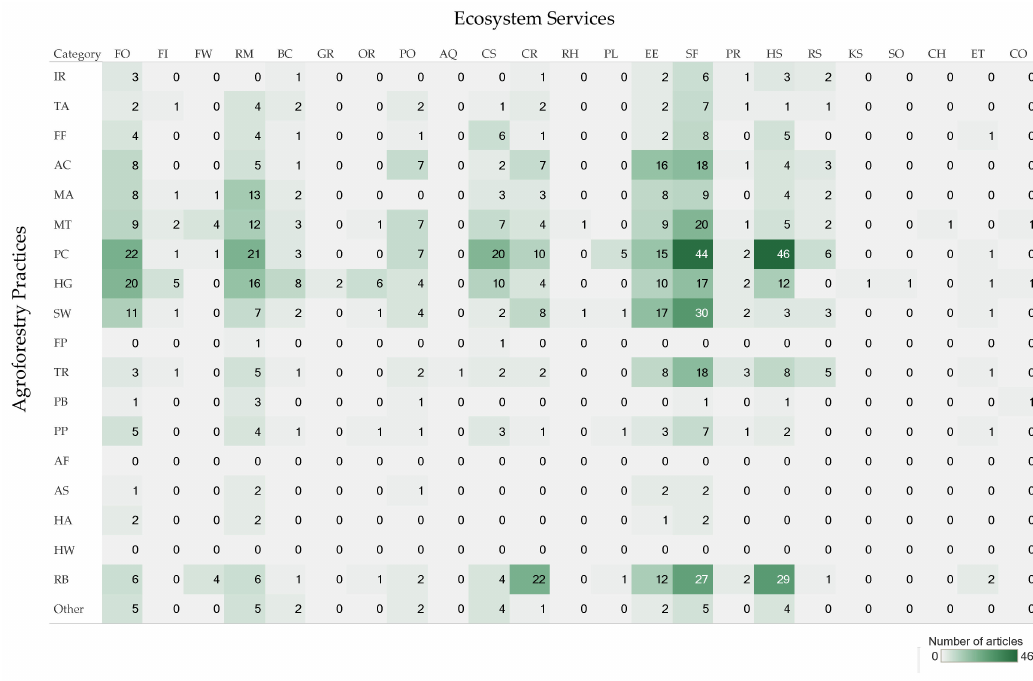
Figure 6. The linkage between agroforestry practices and ecosystem services. Note: The darker the color of the cells, the higher the frequency of